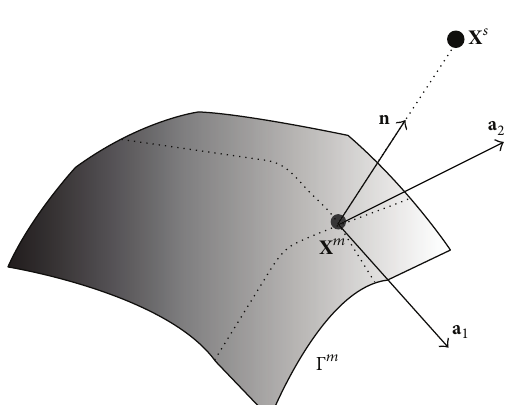
Figure 6: Master and slave surfaces in finite elements.